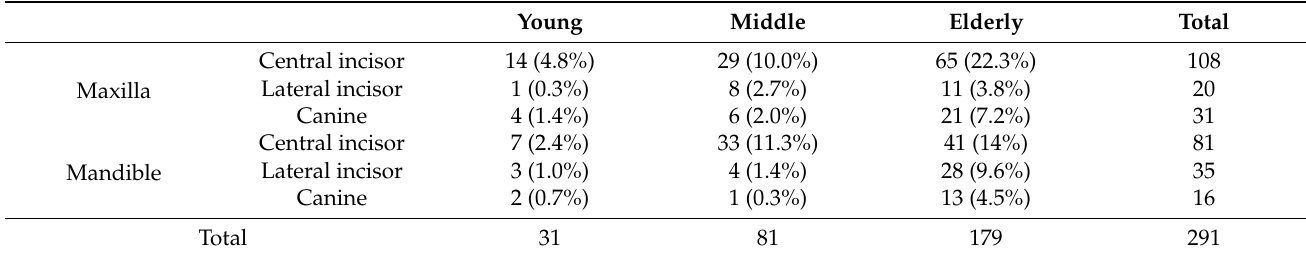
Table 1. Distribution of the enamel cracks in different types of teeth among different age groups.